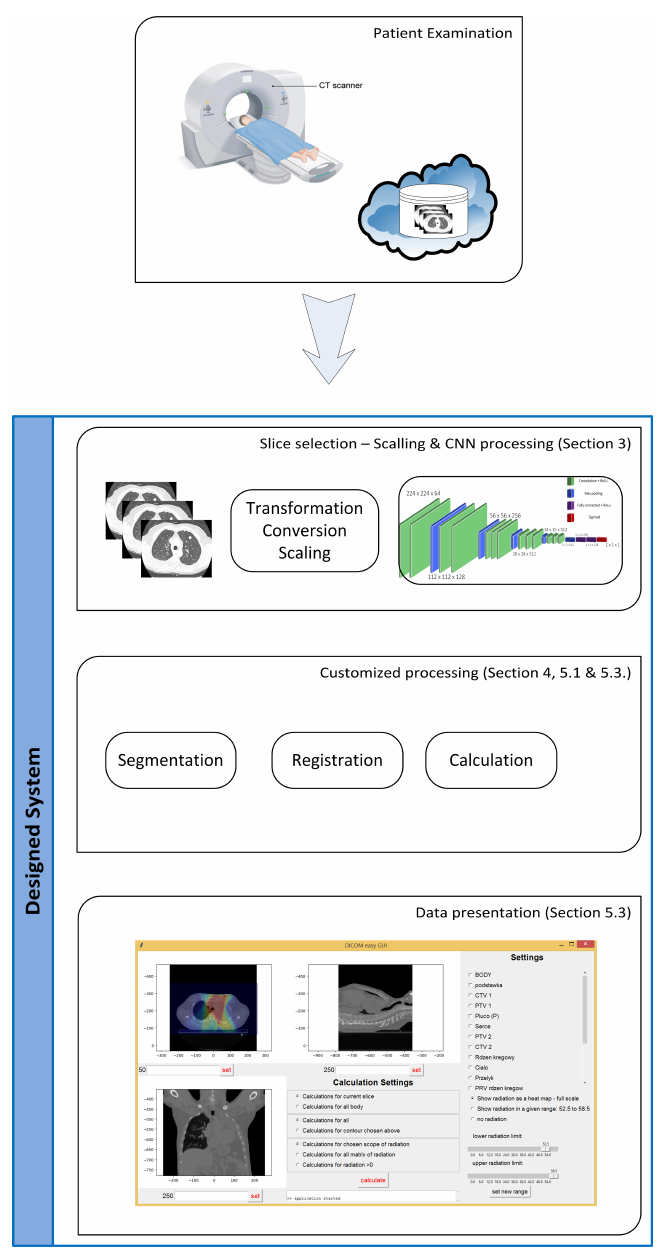
Figure 1. The general dataflow of the proposed